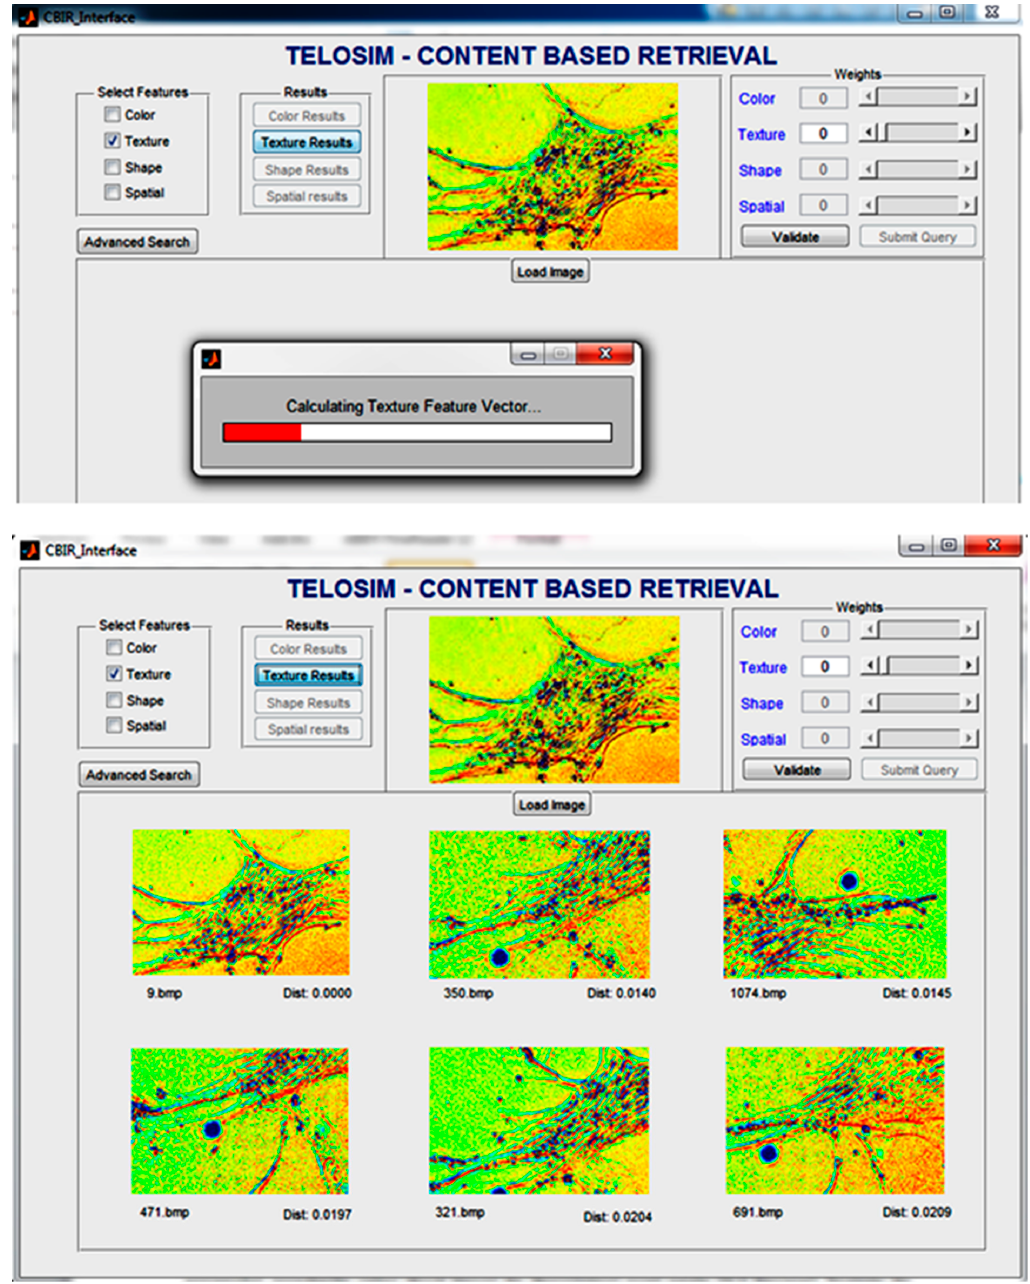
Figure 3. Example of similar images based on texture features. First, the texture feature vector is computed on the query image and then it is compared with vectors from the database.